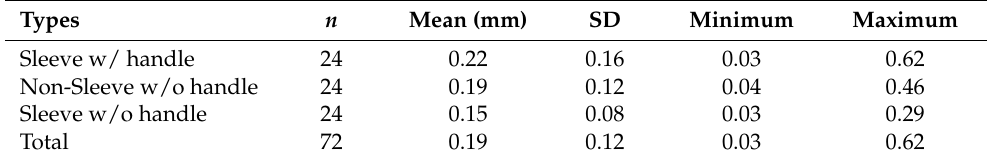
Table 6. Results of descriptive statistics of vertical linear deviation in three types of surgical